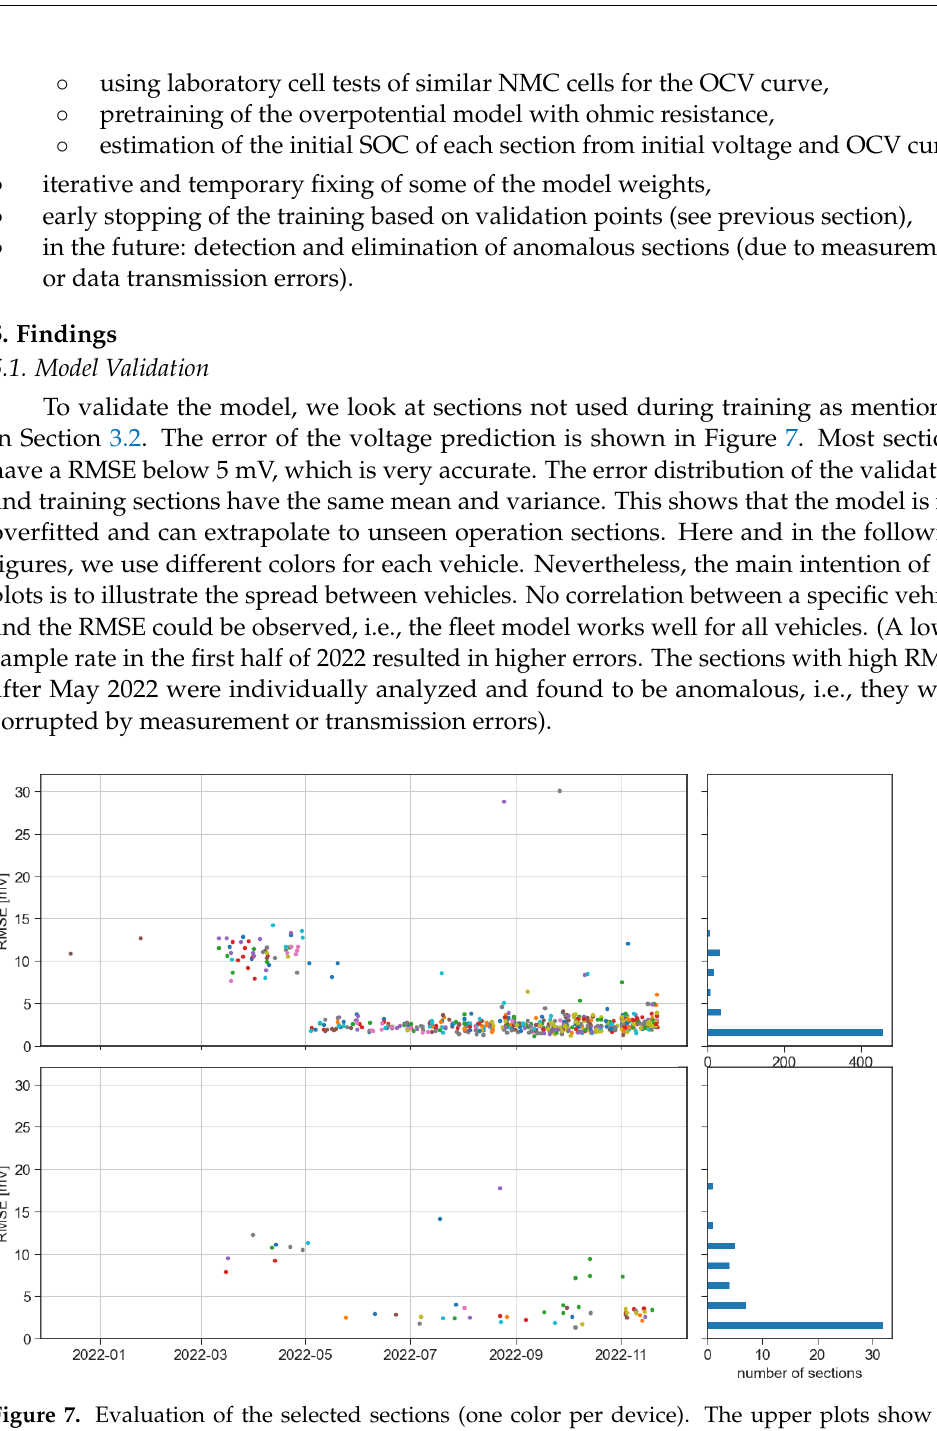
Figure 7. Evaluation of the selected sections (one color per device). The upper plots show the RMSE-vs-time diagram and the corresponding sections-vs-time histogram of the training sections. The lower plots show the same for the validation sections. (See also the remark concerning the change of sampling rate at the end of the section above).